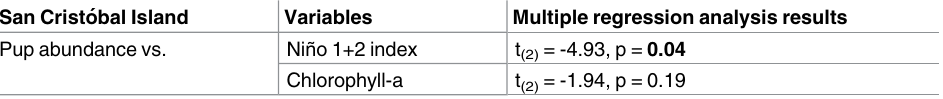
Table 4. Multiple regression analysis results. Relationships betweenpup abundance on San Cristo´bal Island and environmental variablesfrom 2011 to 2015; significantvalues are shown in bold.